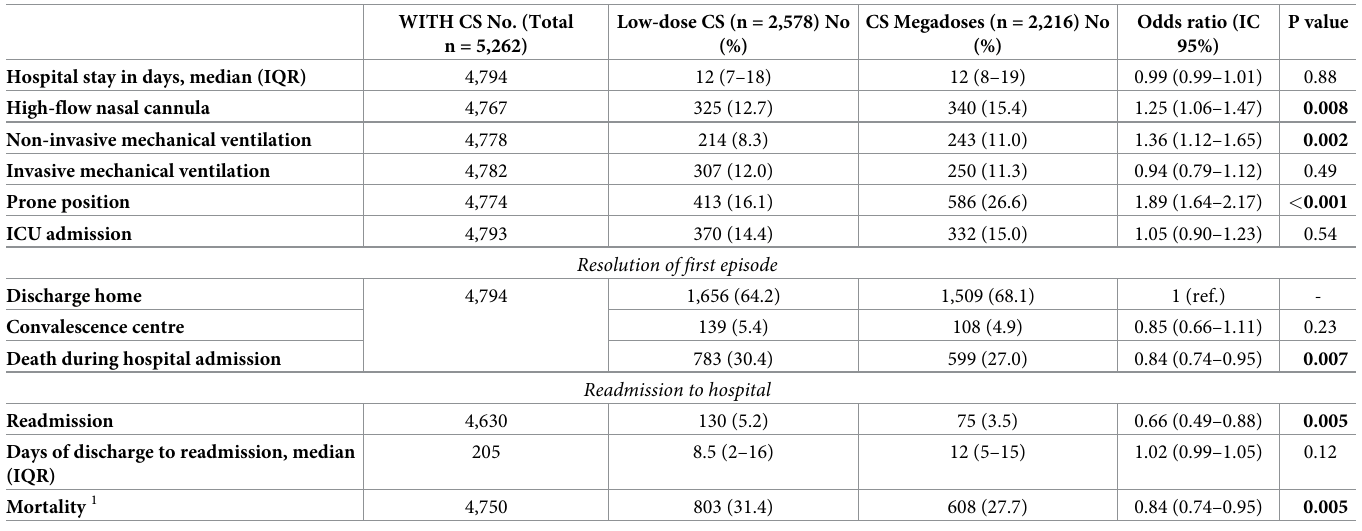
Table 5. Outcome according to the use of